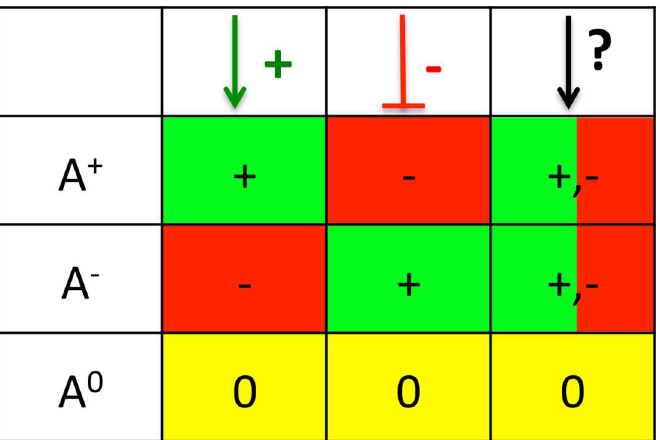
Fig 1. Regulatory effect for all combinations of edge signs (columns) and TF activity changes (rows). E.g. an activating edge (first column) has an activating regulatory effect (+) on the target gene if the associatedTF is more active ( A + ). If the sign of the edge is not known (last column) the regulatory effect can be assumed to be activating or inhibitingdepending on which is neededto explain the target